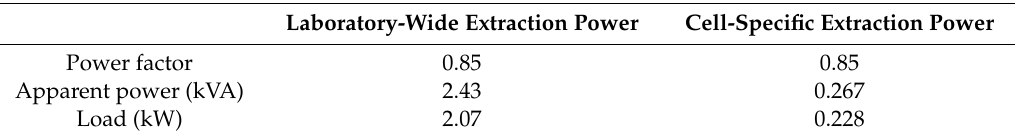
Table 6. Extraction power